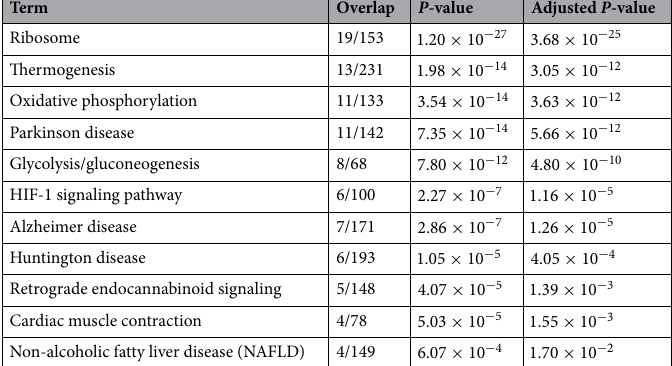
Term Overlap P -value Adjusted P -value Ribosome